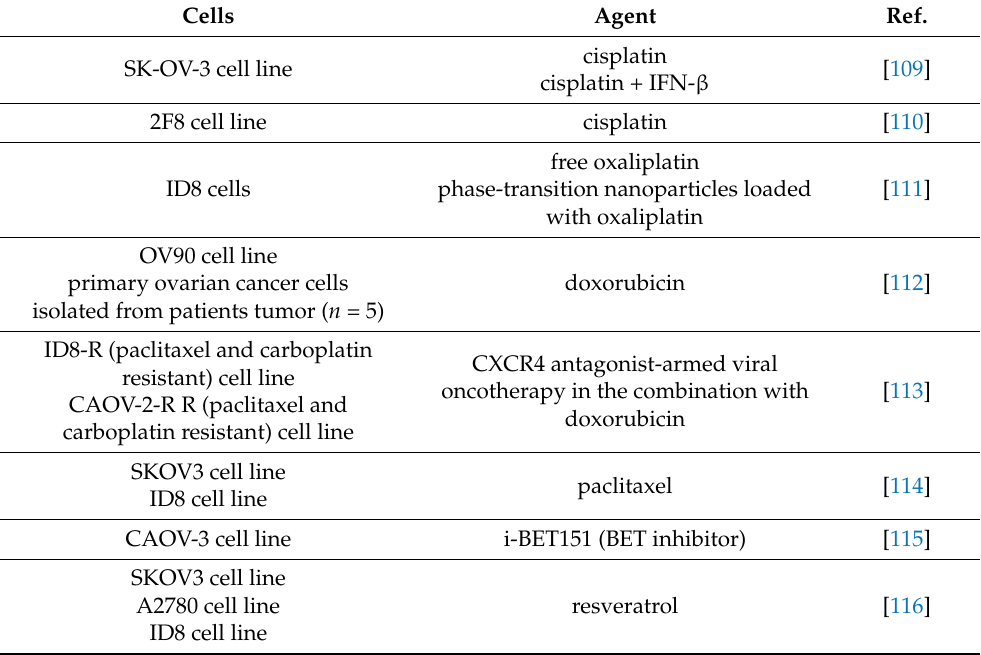
Table 1. The anti-ovarian cancer agents as an inductor of calreticulin (CRT) on ovarian cancer cells.